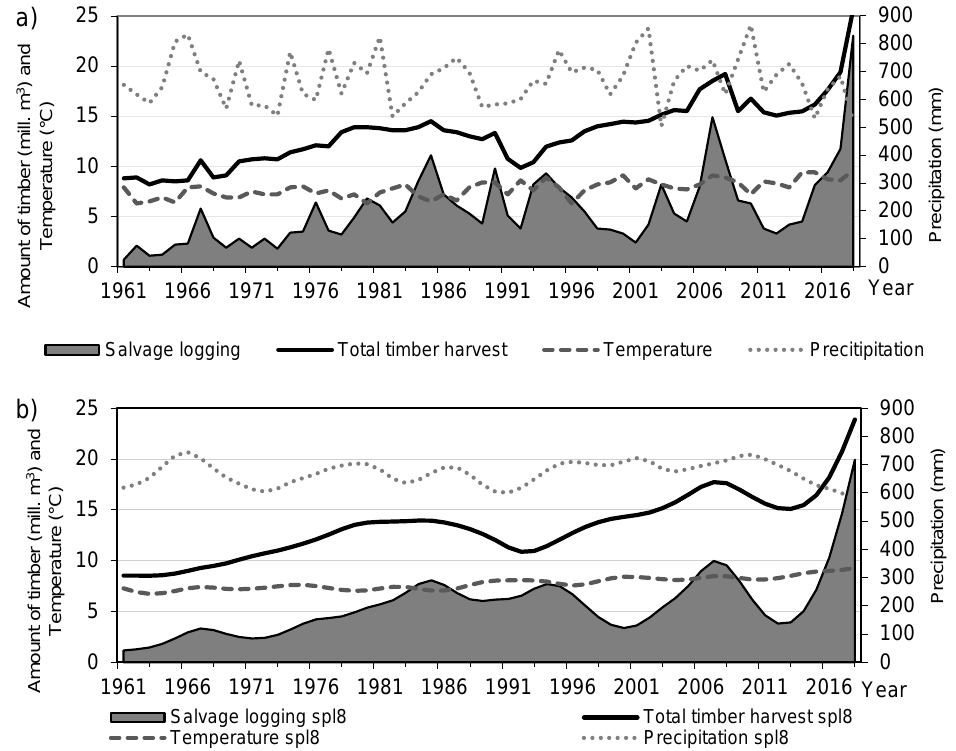
Figure 4. Average annual air temperatures and annual precipitation total in relation to the volume of timber harvested in the Czech Republic: ( a ) The trend of total timber harvest and salvage logging; ( b ) an eight-year spline (spl8) fitted to harvested timber and climate data. Forests 2020 , 11 , x FOR PEER REVIEW